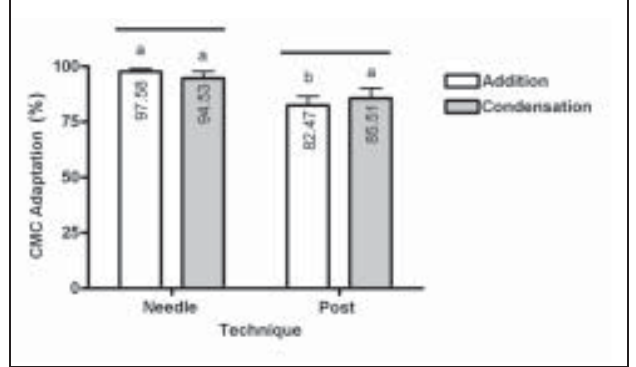
Figure 3. Data from microscopic analysis. Percentage of the root canal occupied by the CMC with the intracanal impression techniques (hypodermic needle or polycarbonate post) using either addition or condensation silicone. Horizontal lines above the columns indicate results without statistical significance (p>0.05). Different letters comparing the same material indicate statistically significant difference